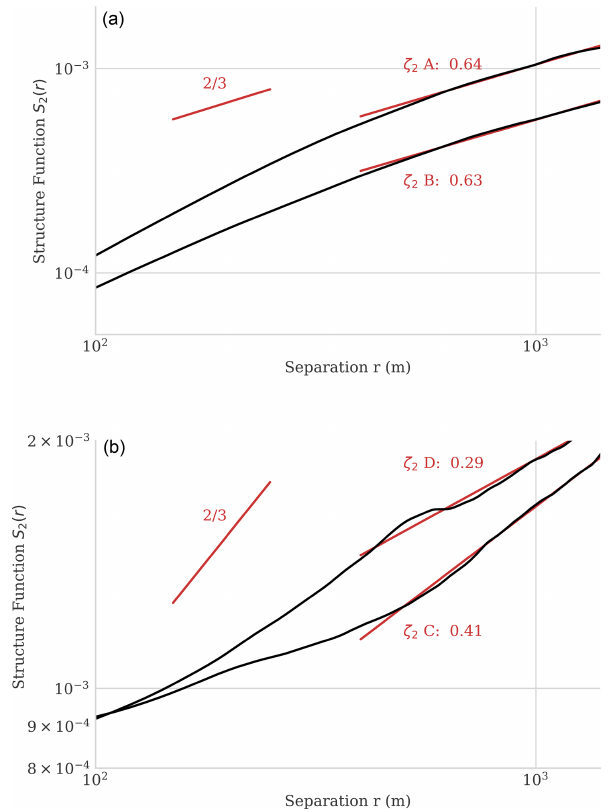
Figure 10. Structure functions for the maps in Fig. 8. (a) Flight lines A and B. (b) Flight lines C and D.